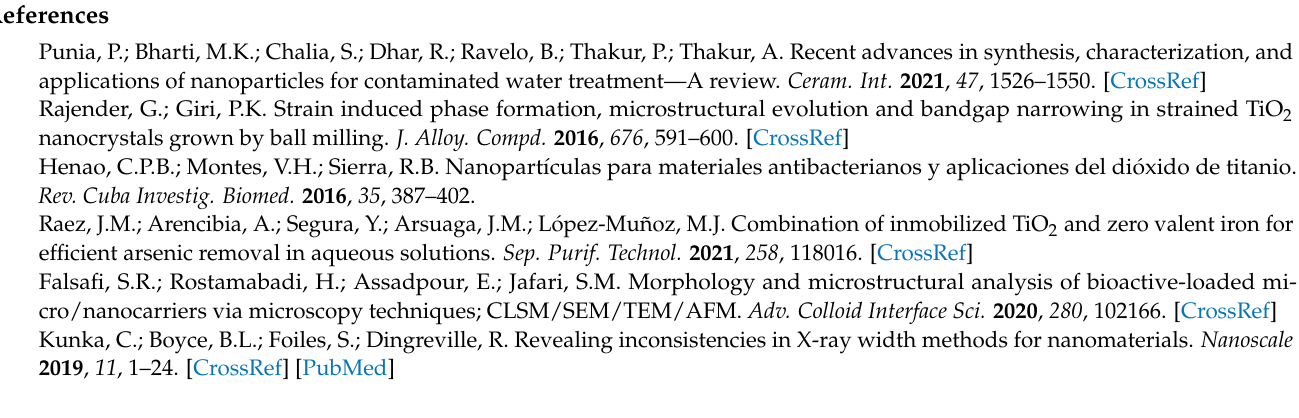
corundum. Figure S2. The pure PXRD pattern of CeO 2 (a) and TiO 2 NPs (b). Figure S3. The modified W–H analysis of CeO 2 (a) and TiO 2 NPs (b), assuming USDM. The modified W–H analysis of CeO 2 (c) and TiO 2 NPs (d), assuming